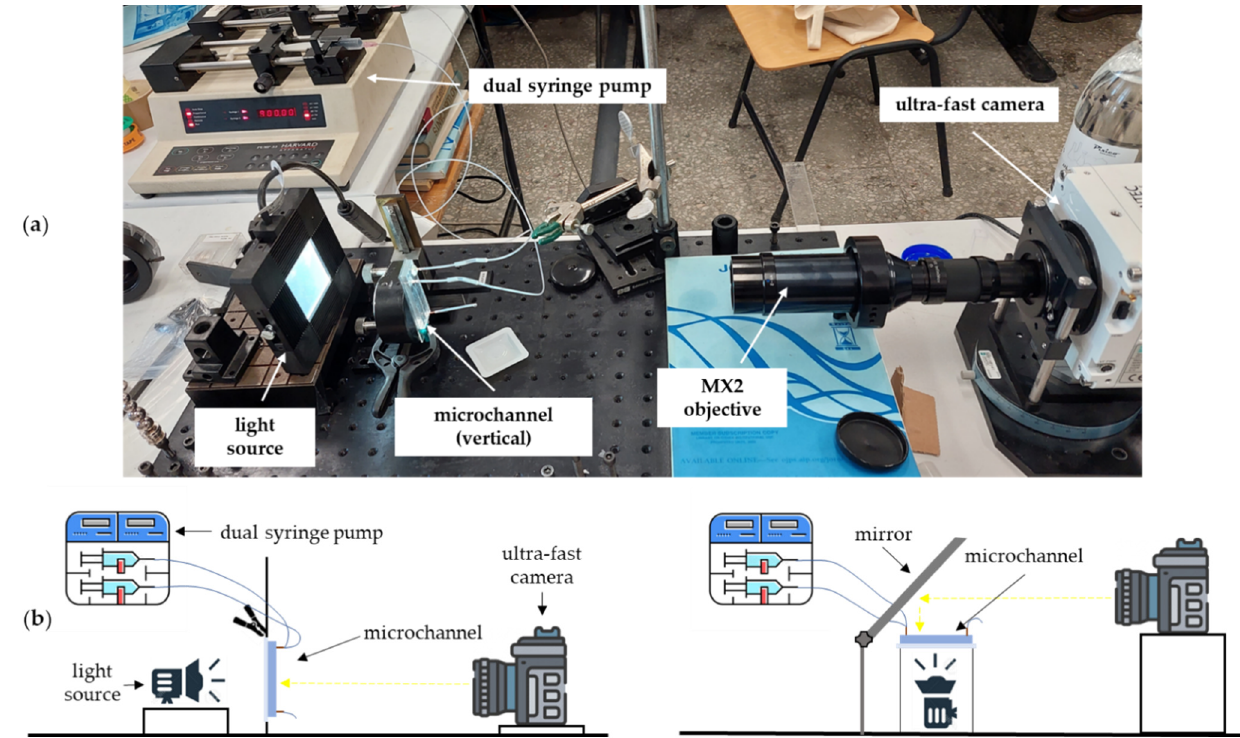
Figure 4. Experimental setup: ( a ) general view; ( b ) positions of the microchannel. The volumetric constant flow rates of water 𝑄 (cid:3050) and oil 𝑄 (cid:3042) were transported in the two branches of the microchannel by a dual Harvard syringe pump. The visualizations were performed with a Phantom VEO 710 fast camera (Vision Research, Wayne, NJ, USA) with up to 5300 fps and a minimum resolution of 1920 × 1080 pixels. The corresponding dimension for 1 pixel was 2.5 μ m. The camera was equipped with a microscopic tube connected to an MX-2 objective obtained from Edmund Optics.